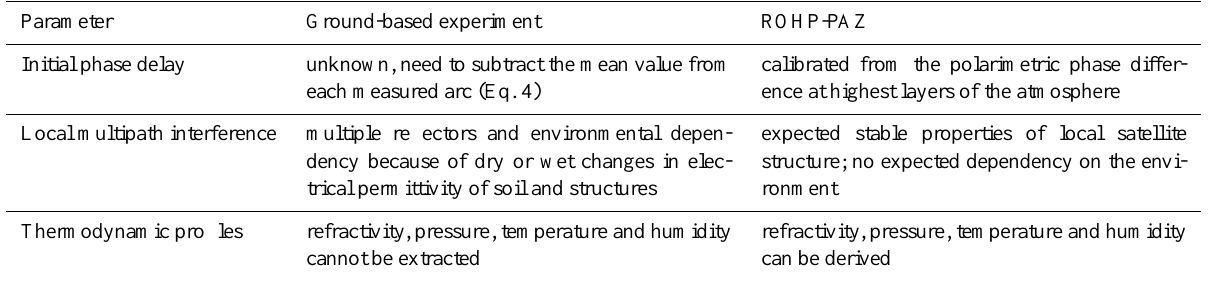
Table 1. Summary of the relevant differences expected between the ROHP-PAZ spaceborne experiment and the conducted ground-based field campaign.